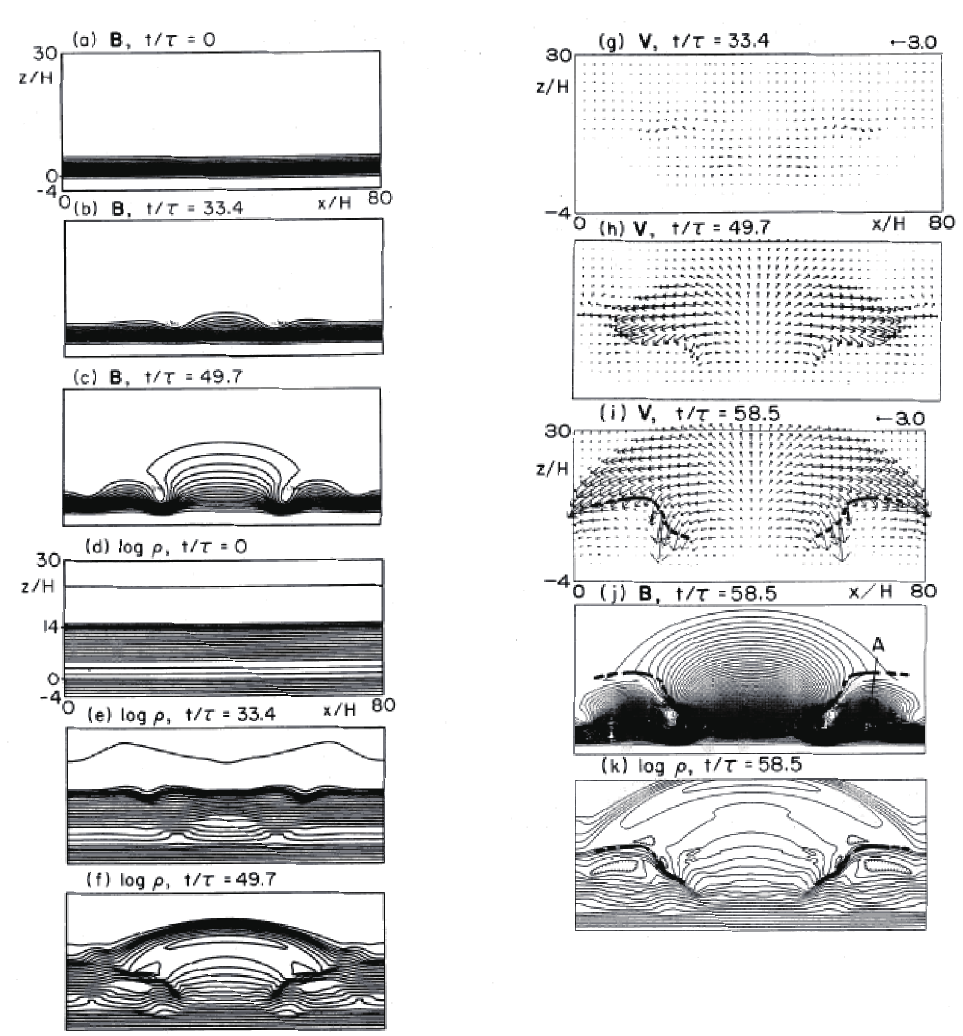
Figure 17: 2D MHD simulation of undular mode instability of a flux sheet in the photosphere. Image reproduced with permission from Shibata et al. (1989b), copyright by